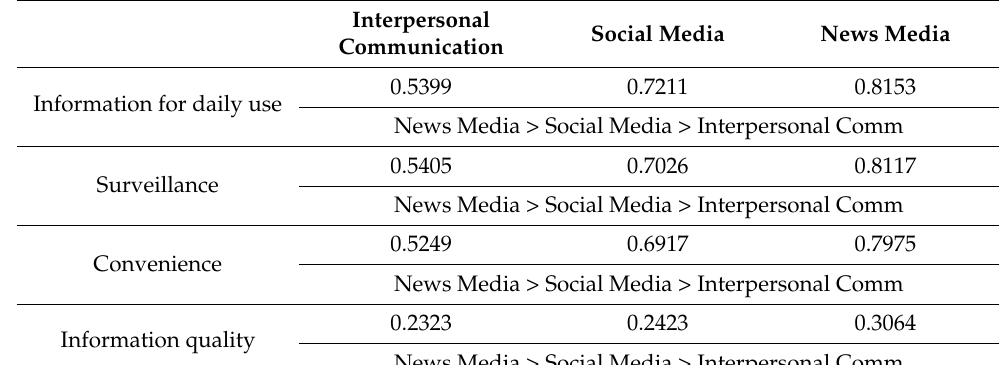
Table 3. Niche breadth of the four gratifications.